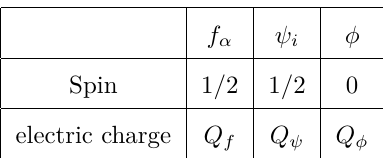
Table 1 . Particle contents of the general model we consider where the electric charges Q f , Q ψ and Q φ can be arbitrary